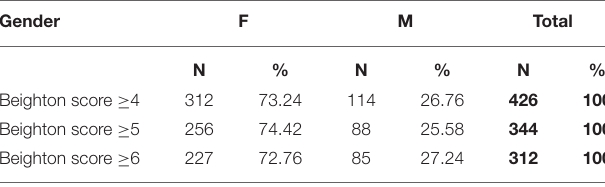
TABLE 2 | Absolute and percentage distribution of Beighton scores ≥ 4, ≥ 5, and ≥ 6 by gender in the total sample.